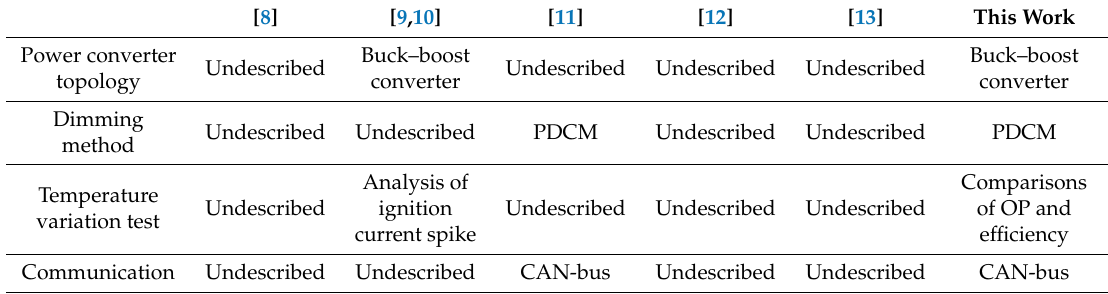
Table 1. Comparisons of power converter topologies and control topologies for laser headlights.